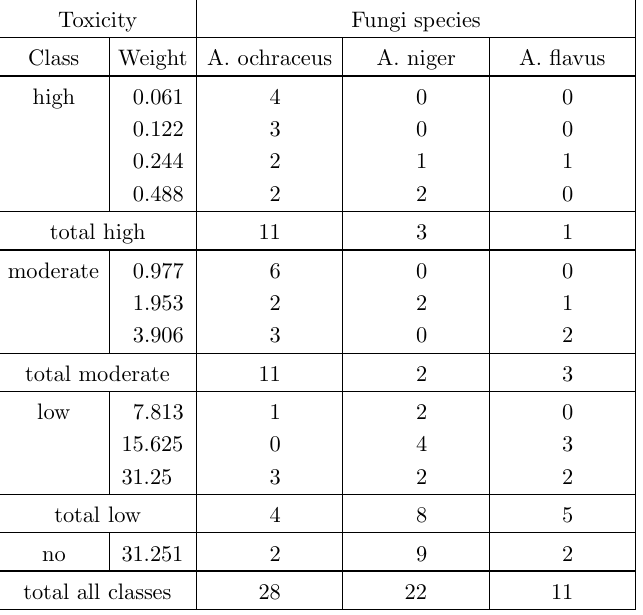
Table 1. The data under study: distribution of the measured toxicity Toxicity Fungi species Weight A.